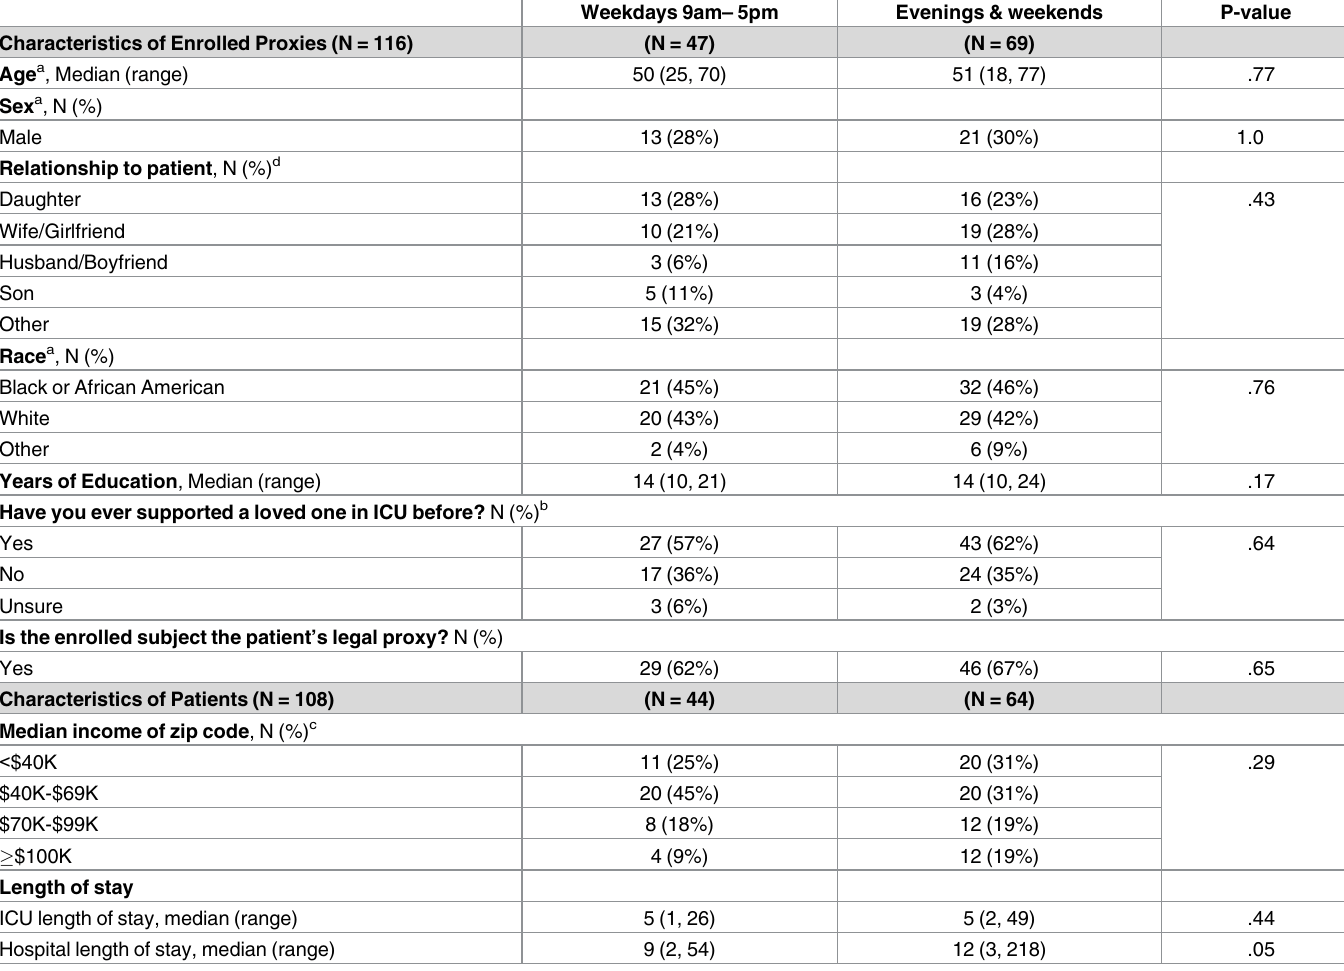
Table 3. Characteristics of enrolled proxies and their loved ones by enrollment